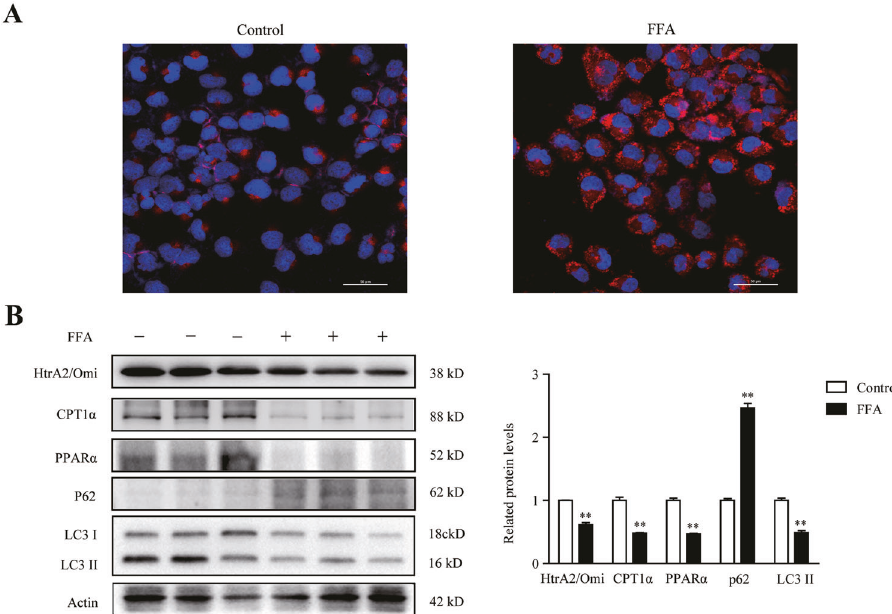
Fig. 5 Effect of FFA on HtrA2/Omi expression, limiting enzyme of β -oxidation, and autophagy-associated proteins in vitro model of NAFLD. A Nile red staining of cells, scale bars: 50 μ m ( n = 3). B Western blot analysis of HtrA2/Omi, CPT1 α , PPAR α , p62, and LC3I/II in different groups. The histogram shows the ratio quanti fi cation of band intensities ( n = 3). Data are shown as means ± SEM. Student ’ s t test was used. ** P < 0.01 vs. control